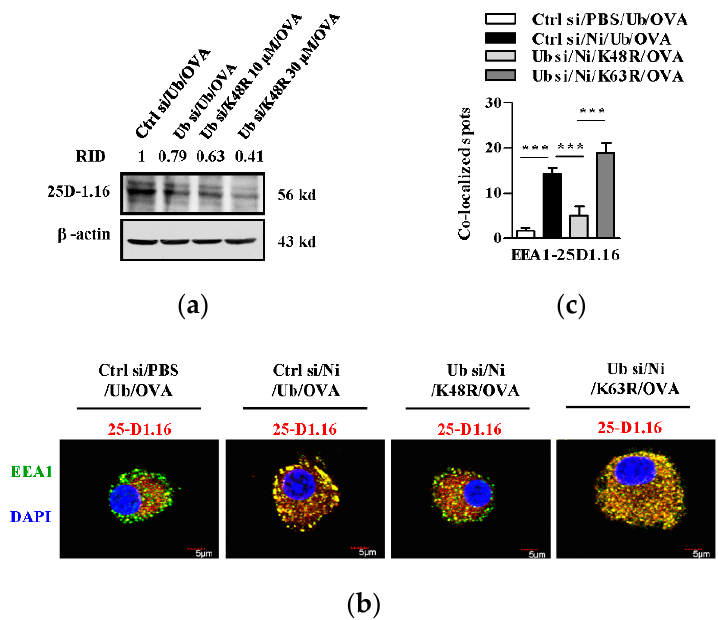
Figure 2. K48-linked ubiquitination contributes to nicotine-increased cross-presentation in bone- marrow-derived dendritic cells. ( a – c ) Murine ubiquitin-deficient and control BM-DC were stimulated with PBS ( a ) or nicotine (10 − 7 mol/L) ( b ) for 12 ~ 16 h. Then, the cells were replenished with K48R-Ub, K63R-Ub, or WT-Ub (30 × 10 − 6 mol/L or indicated concentration) prior to further incubation with ovalbumin (50 µg/mL). Cross-presented OVA was assessed by Western blot analyses ( a ) or confocal microscope ( b , c ). Cross-presented OVA was stained with 25-D1.16 (red) and endosome was stained with EEA1 antibody (green) respectively; nuclei were counterstained with DAPI (blue). The co-localized spots of 25-D1.16 with EEA1 were counted and analyzed ( c ). For Western blot analyses, β -actin was used as an internal control. Protein level was quantified by ImageJ software and presented as related integrated density (RID). Data are presented as the mean ± SEM, *** p < 0.001, one-way ANOVA with Newman-Keulspost test. One representative from three independent experiments is shown. Ni: nicotine; Ub: ubiquitin; si: siRNA; EEA1: early endosome marker; 25D1.16: antibody specific to SIINFEKL-H2Kb complex; OVA: ovalbumin.